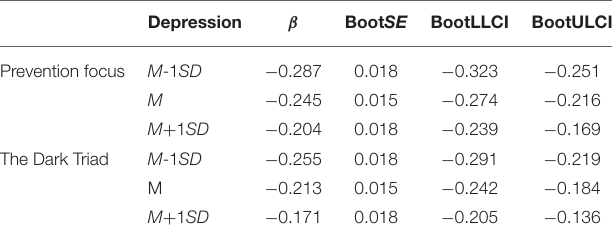
TABLE 3 | Mediating effects and direct effects on different levels of depression.